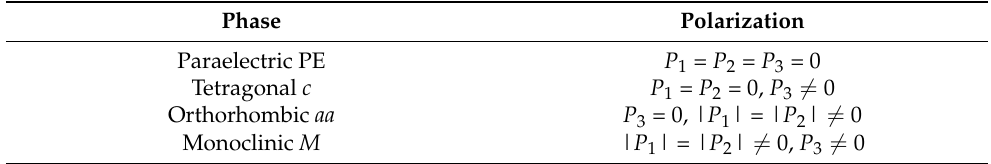
Table 2. The polarization components of the epitaxial PIN–PMN–PT thin films in the absence of an external electric